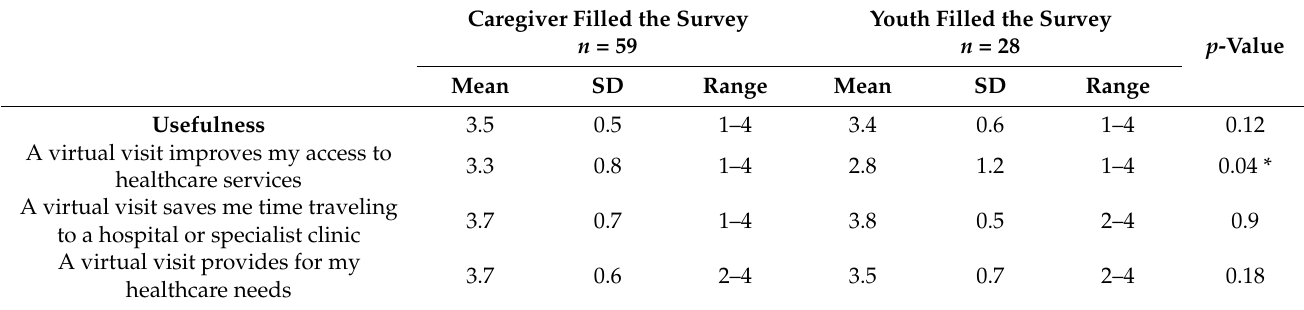
Table 2. Usability of virtual visits: Telehealth Usability Questionnaire responses by caregivers and trans youth 1